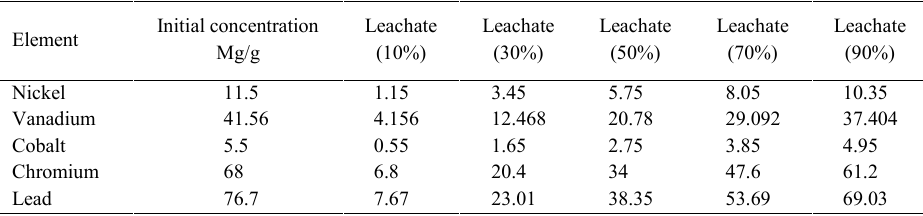
Table 7: Different leachate concentration of heavy metals (Values are expressed as mg/kg)